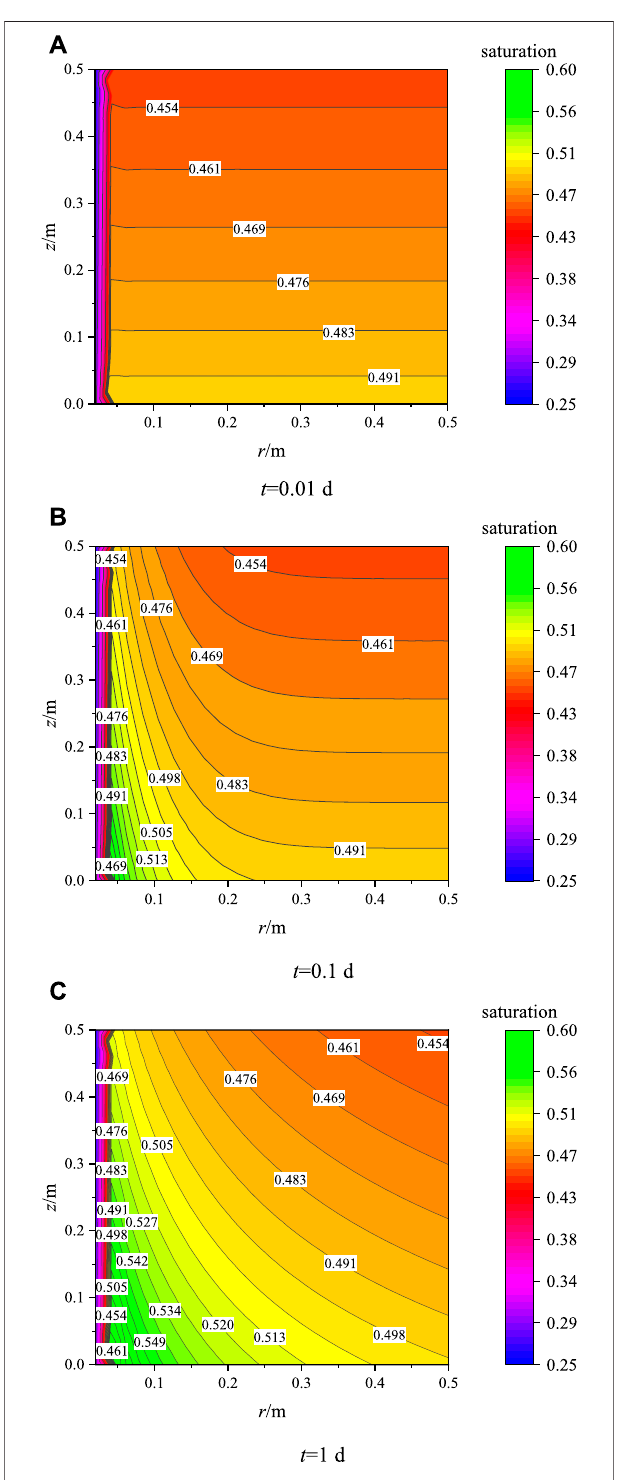
FIGURE 9 | Variation of saturation with time on the symmetric